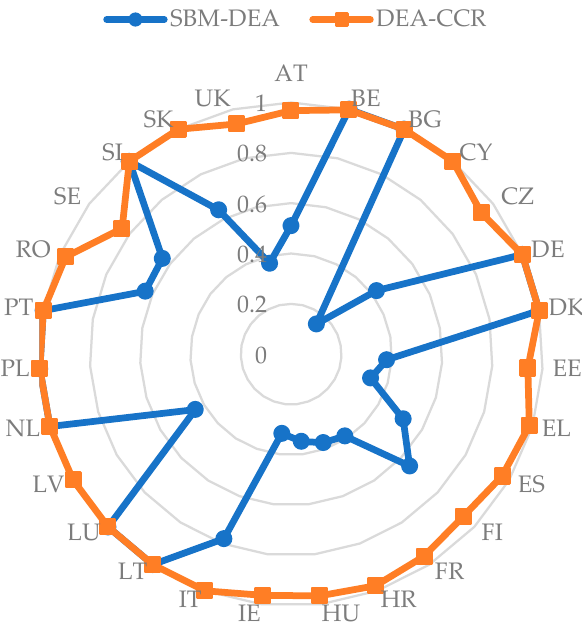
Figure 11. Efficiency of road freight transport sectors according to the DEA-CCR and SBM-DEA model. Source: Own elaboration.